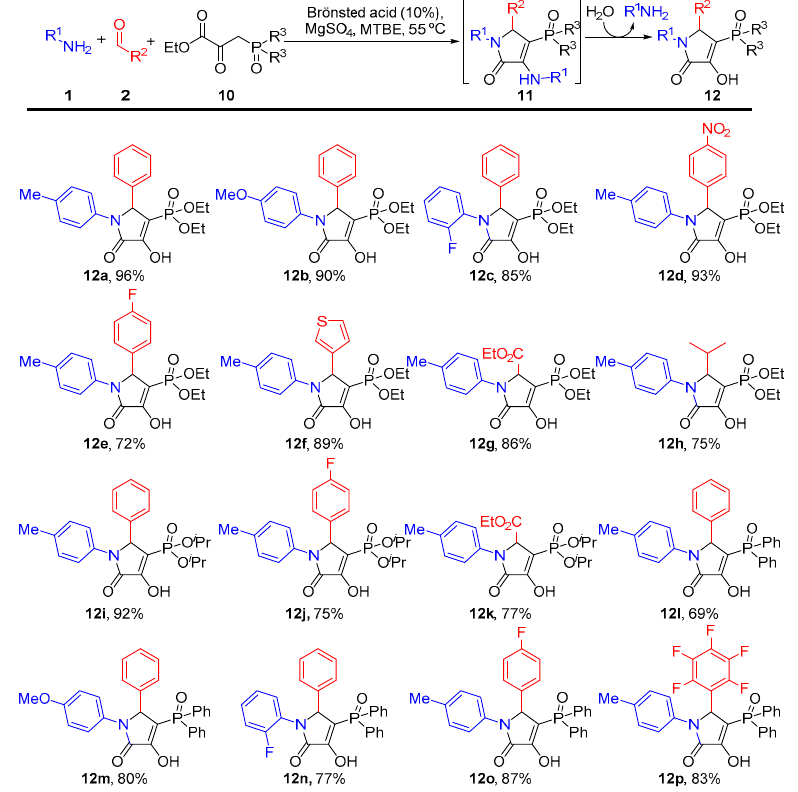
Figure 3. 3-Hydroxy 3-pyrrolin-2-ones 12 obtained.